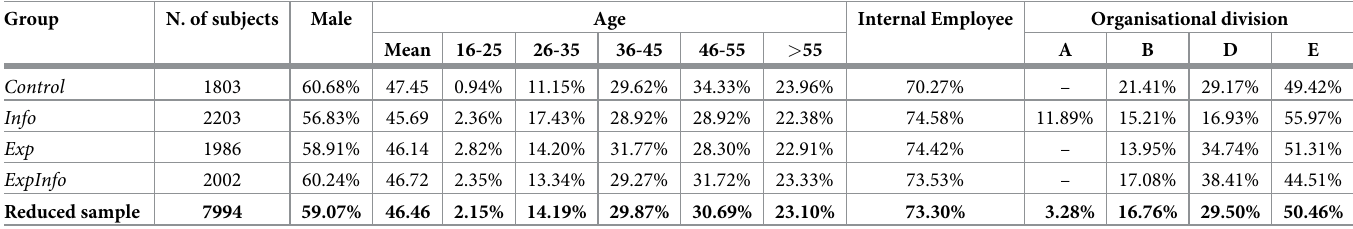
Table 3. Descriptive statistics after the exclusion of division C. Group N. of